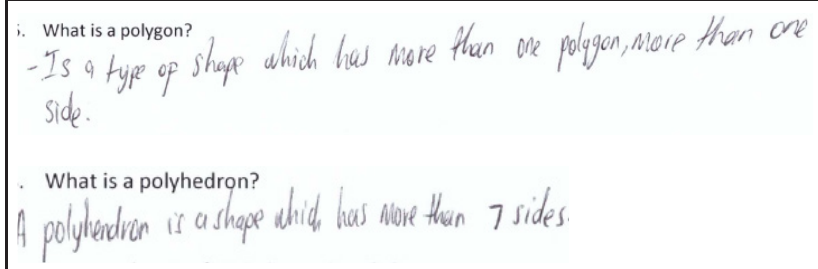
Figure 6: Erroneous definitions of a polygon and a polyhedron questions on perimeter, area and volume. Figure 7 provides examples of wrong answers to two of these